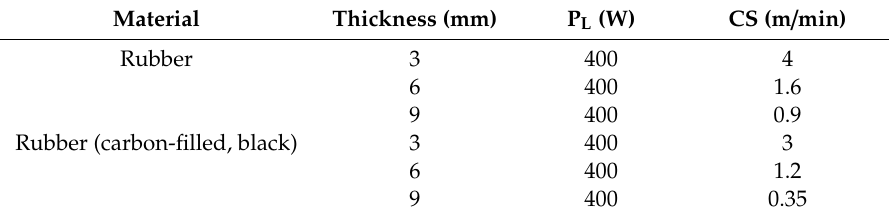
Table 3. Cutting parameter levels for selected materials in the chemical degradation mechanism [22].